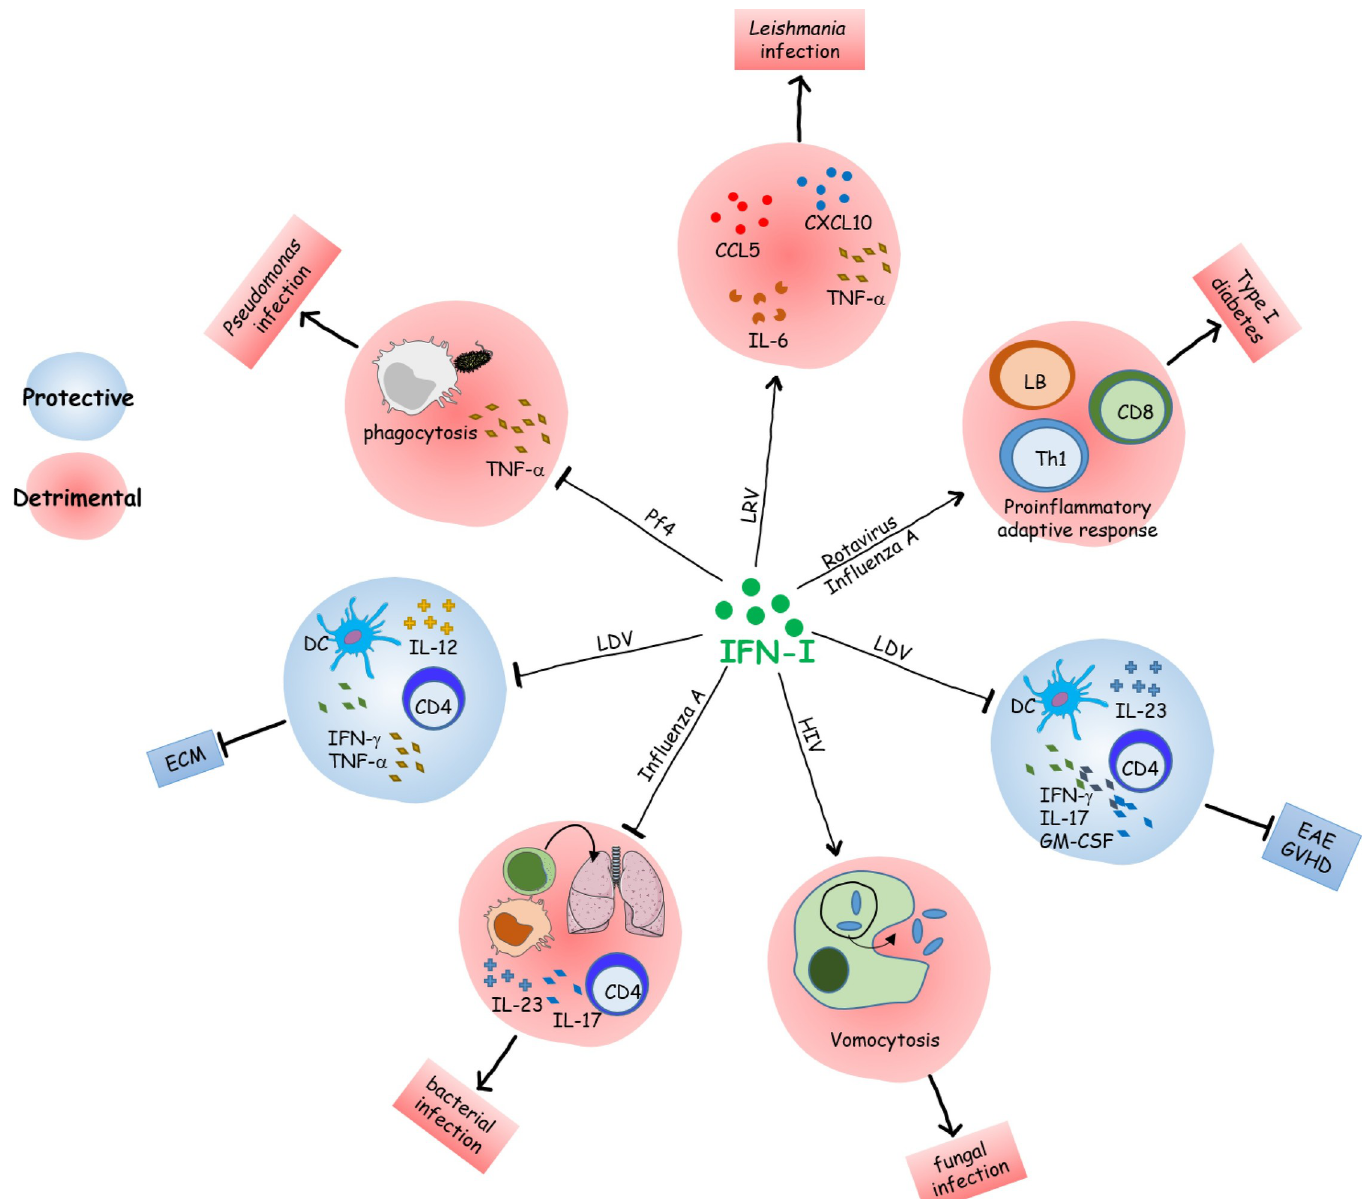
Fig 1. Functional modulation of immune cells by infection-mediated IFN-I. Several immune functions can be regulated negatively or positively by IFN-I produced during concomitant pathologies, resulting in protective or detrimental phenotypes. DC AU : AbbreviationlistshavebeencompiledforthoseusedinFigs 1 (cid:0) 4 : Pleaseverifythatallentriesarecorrect : , dendritic cell; EAE, experimental autoimmune encephalomyelitis; ECM, experimental cerebral malaria; GVHD, graft versus host disease; IFN-I, type I interferon; LDV, lactate dehydrogenase-elevating virus; LRV, Leishmania parasite-borne RNA